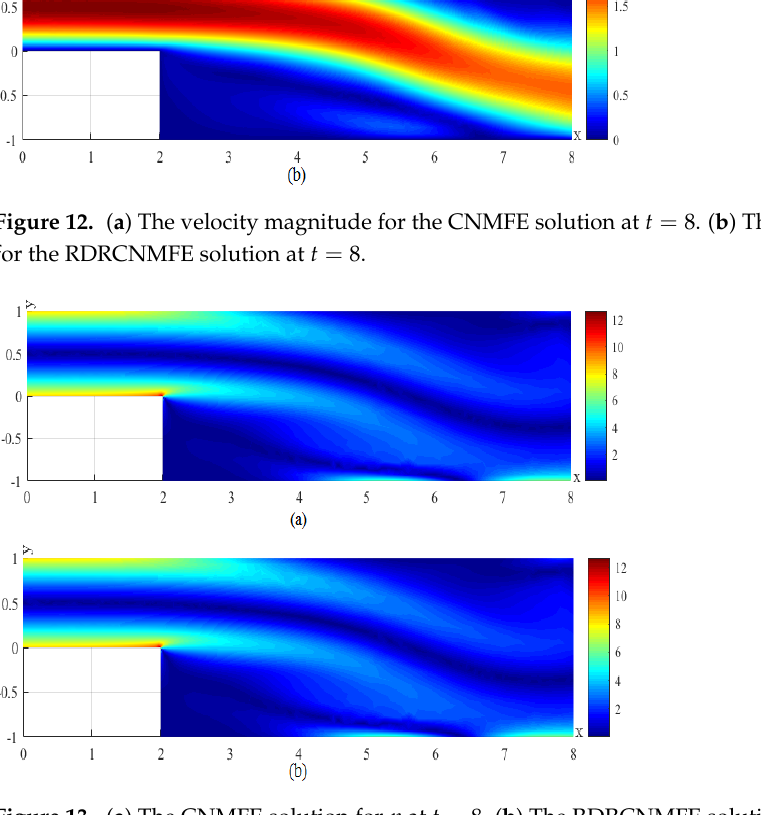
Figure 13. ( a ) The CNMFE solution for p at t = 8. ( b ) The RDRCNMFE solution for p at t = 8.